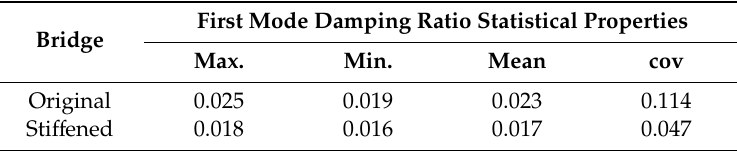
Table 7. Damping ratio for original and sti ff ened bridges.